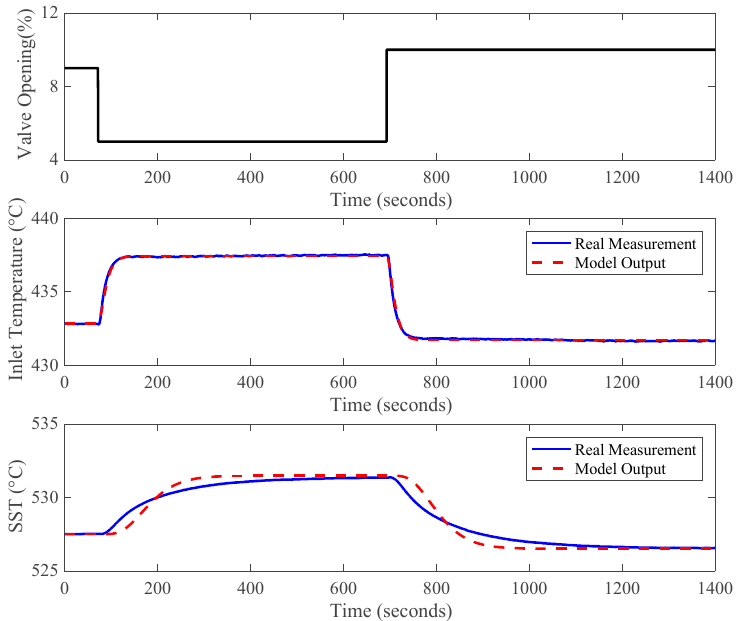
Figure 16. The comparisons between the model output and the real measurement.